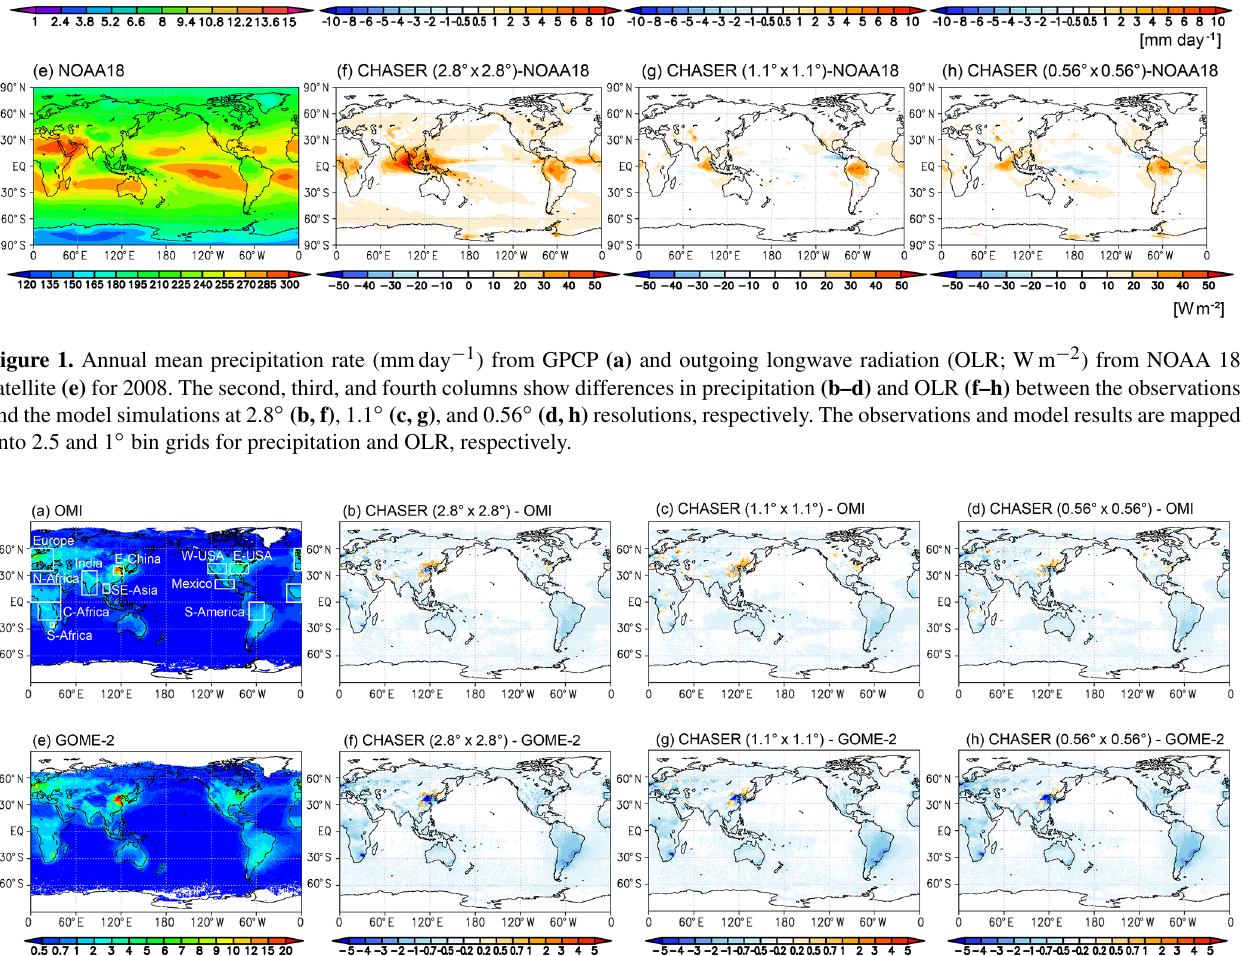
observed global spatial variation well, with r > 0 . 9 in